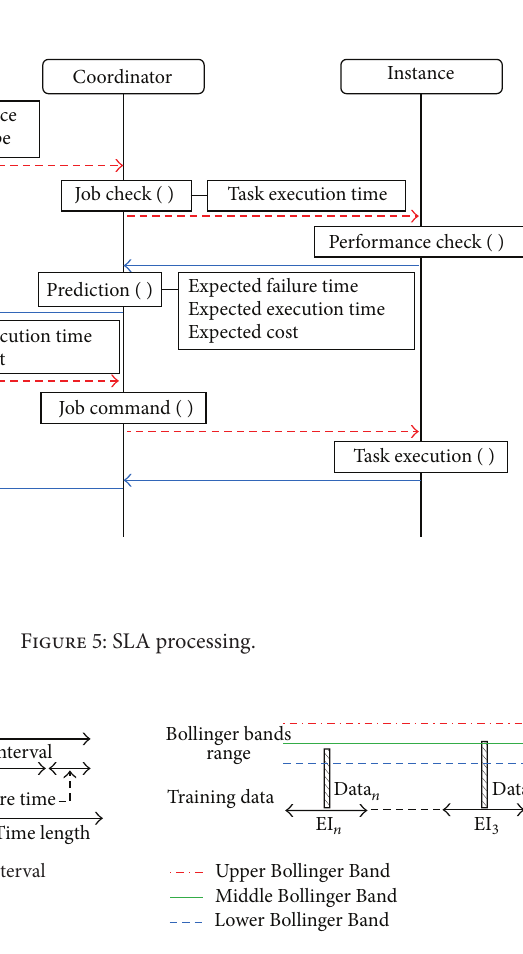
Figure 7: Bollinger Bands acquisition.